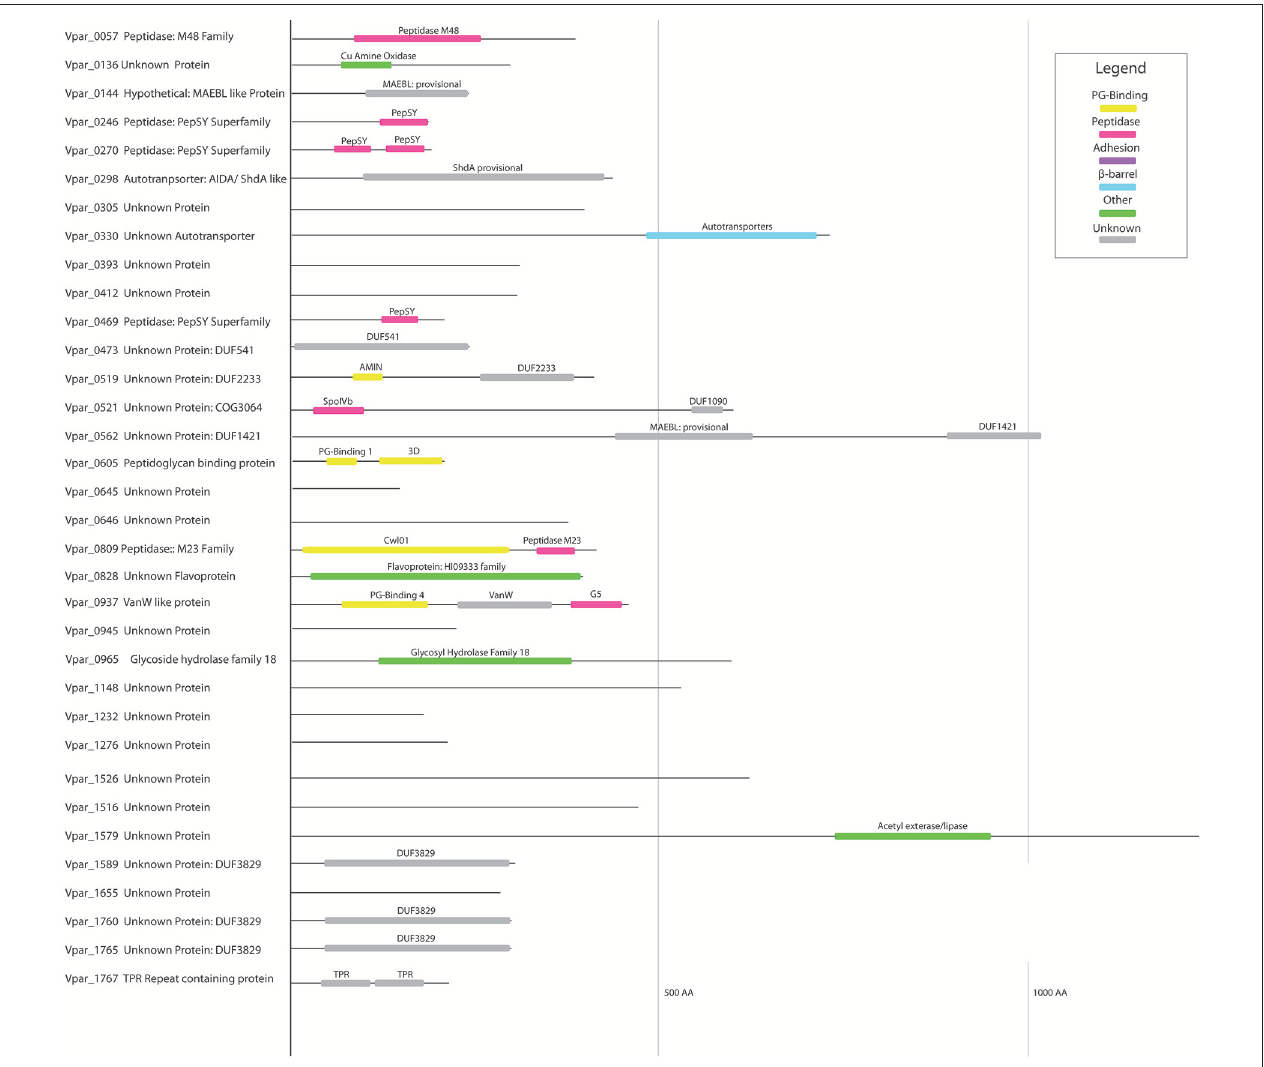
FIGURE 7 | Domain structure of unknown OM proteins. Protein domains identified in all poorly annotated OM proteins at the NCBI CDD database, and colored according to proposed function based on CDD annotation.